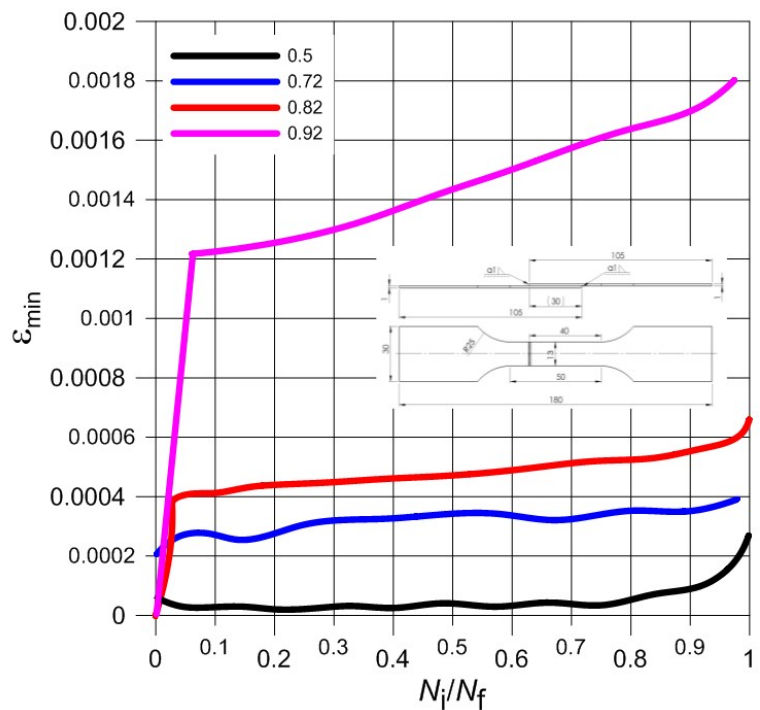
Figure 8. The course of maximum total strain during the fatigue load process of Type 3 samples.